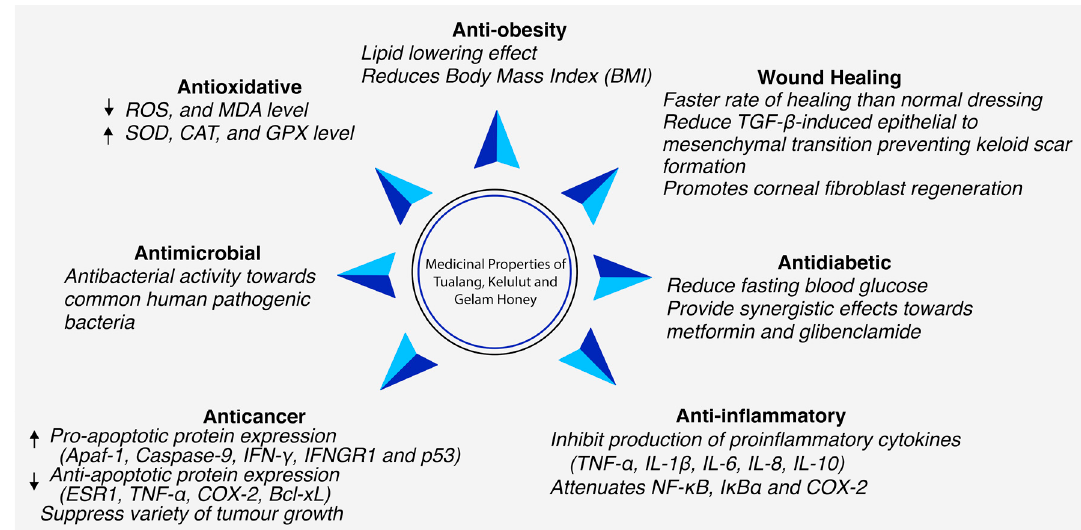
Figure 1. The medicinal properties of Tualang, Gelam and Kelulut honeys. ROS: reactive oxygen species; MDA: